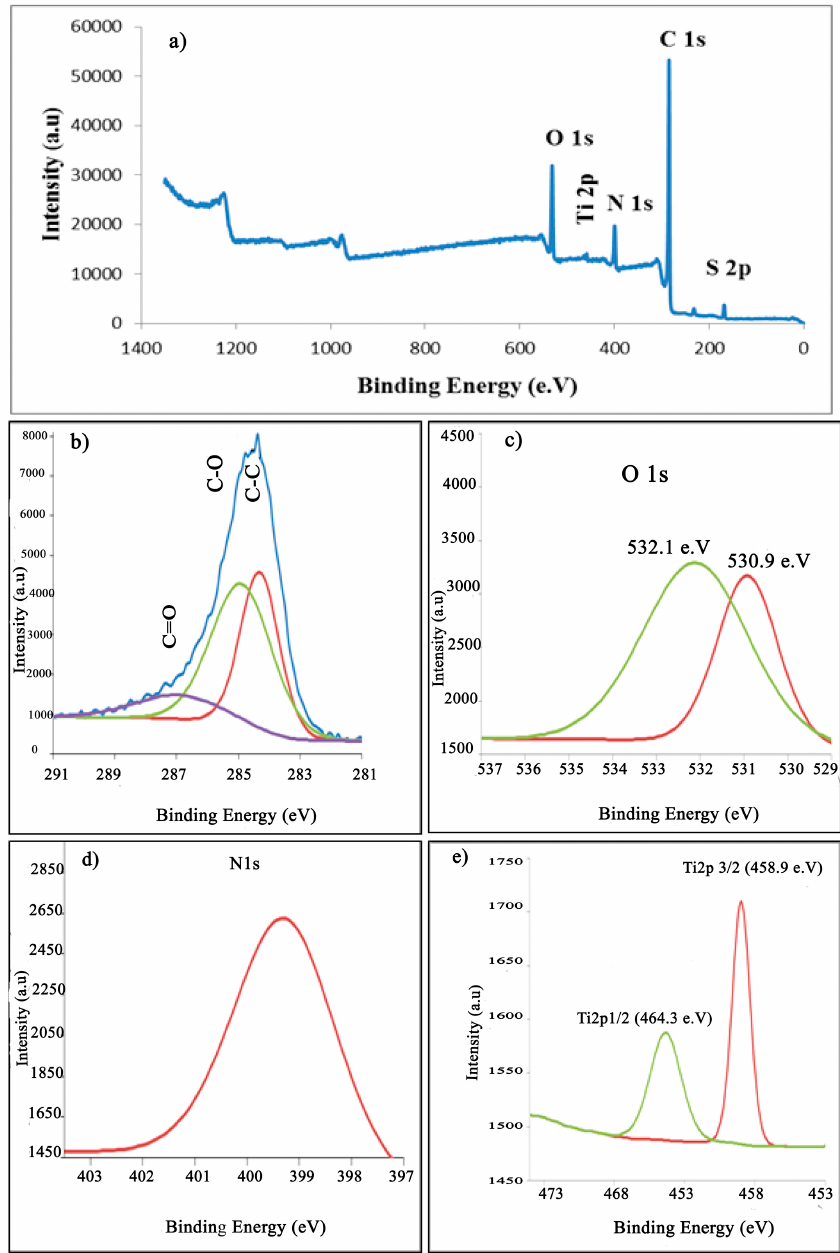
Figure 13. ( a ) XPS survey of the PANI / TiO 2 (0.4g / L) nanocomposite thin film on ITO, ( b ) C1s spectra, ( c ) O1 s spectra, ( d ) N1 s spectrum, and ( e ) Ti2 p